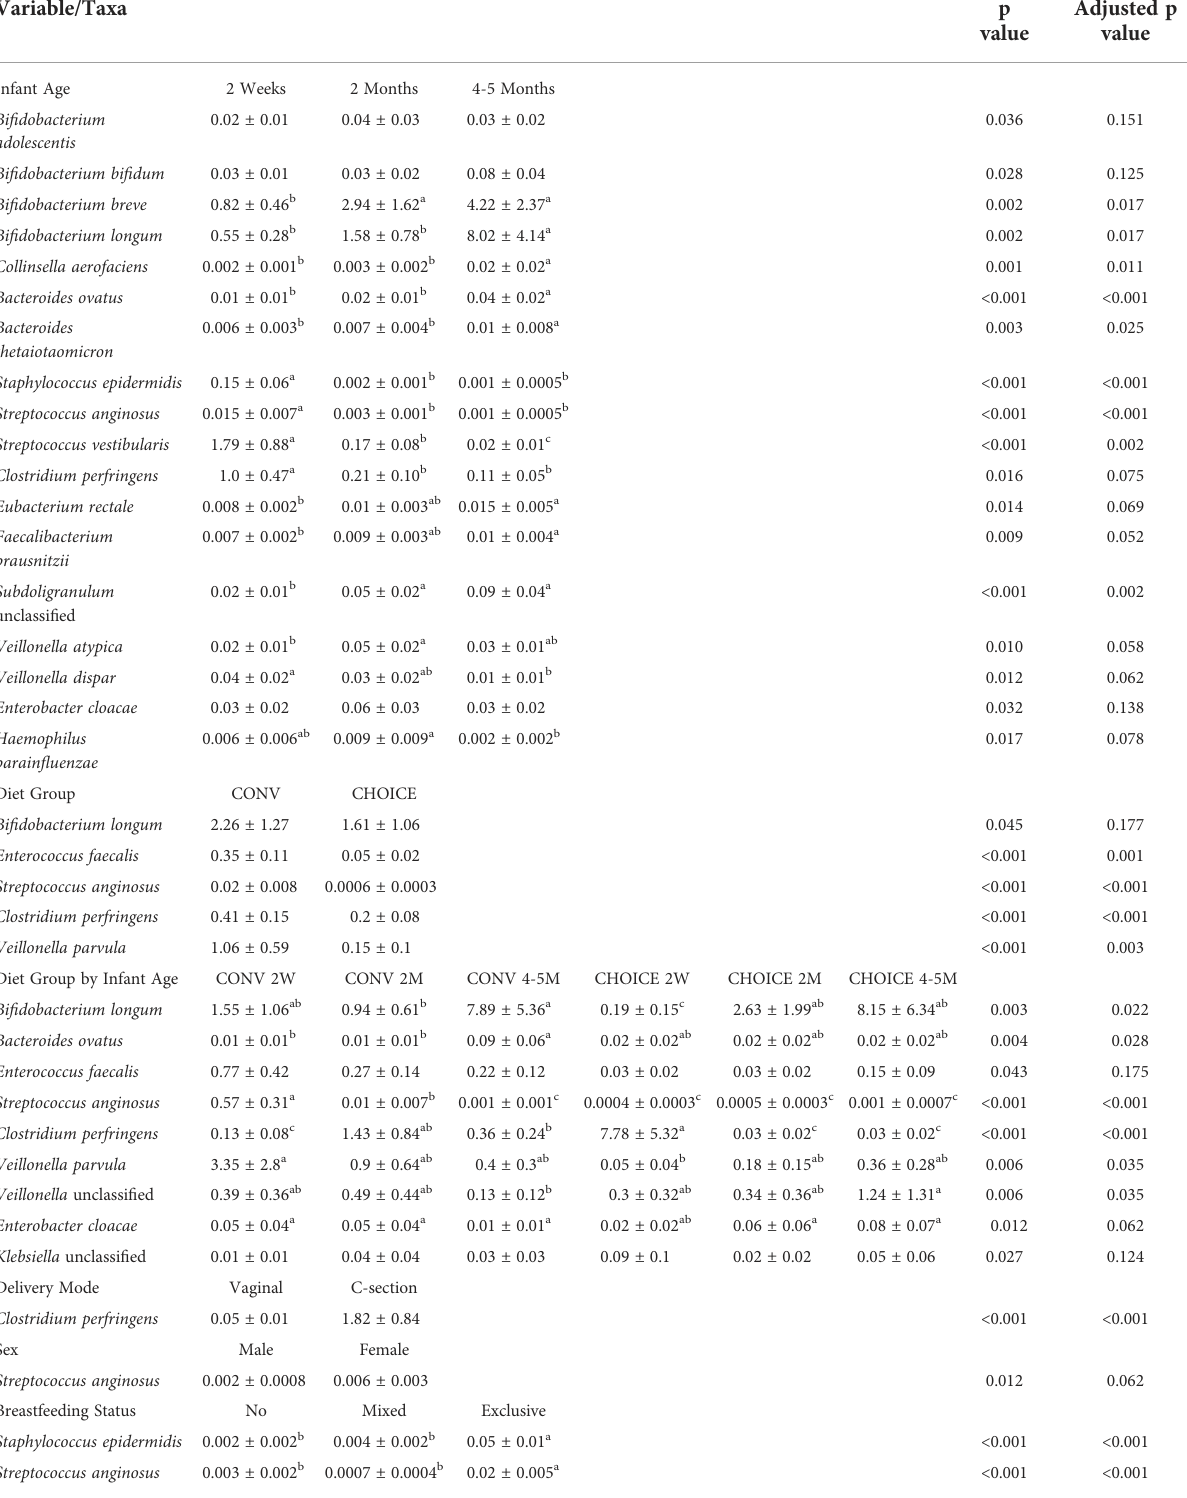
TABLE 6 Variables associated with infant species – level taxa determined by negative binomial regression.